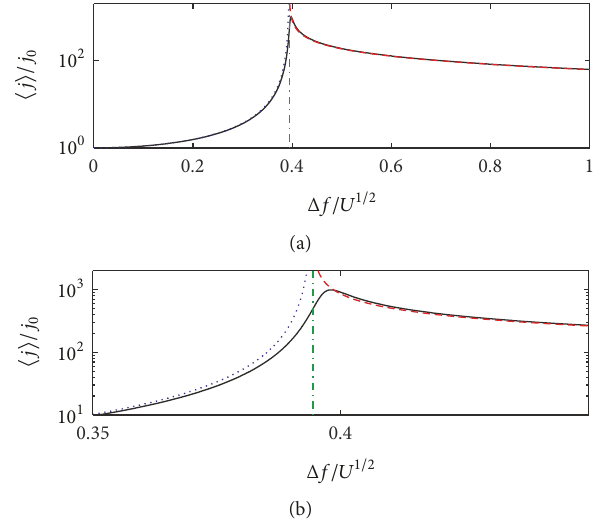
Figure 2: The adiabatic approximation (solid curve) and its approx- imations (the dotted and dashed curves). The lower panel is a zoom- in of the transition zone. The simulations parameters were 𝐿√𝑈 = 7 , /√𝑈 = 0.5 , Ω/𝑈 = 0.8 , 𝜔/𝑈 = 0.01 , and Δ𝑓 𝑓 0 presented by the vertical line.